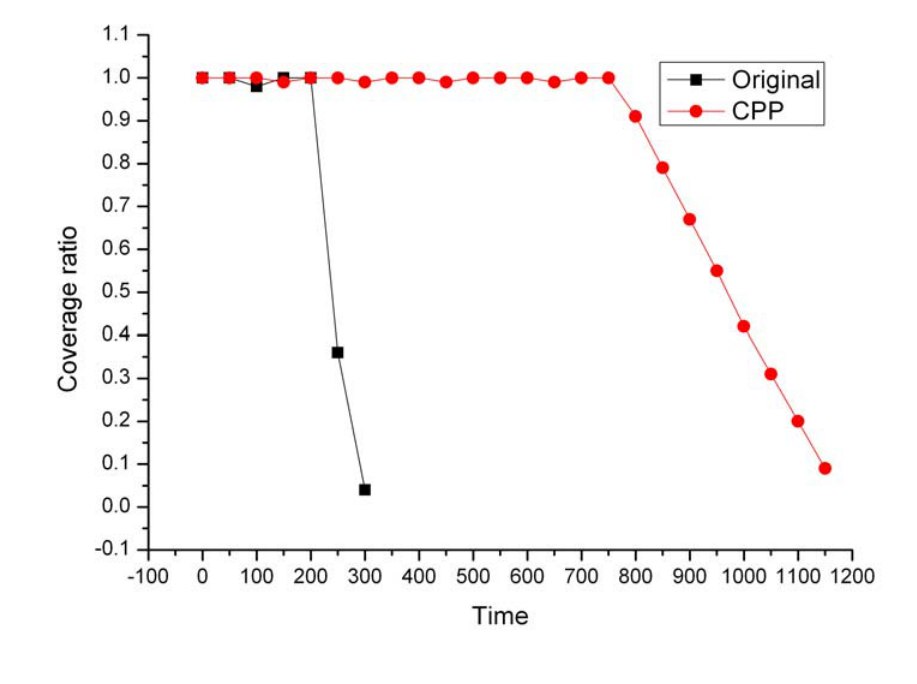
Figure 10. Dynamic coverage